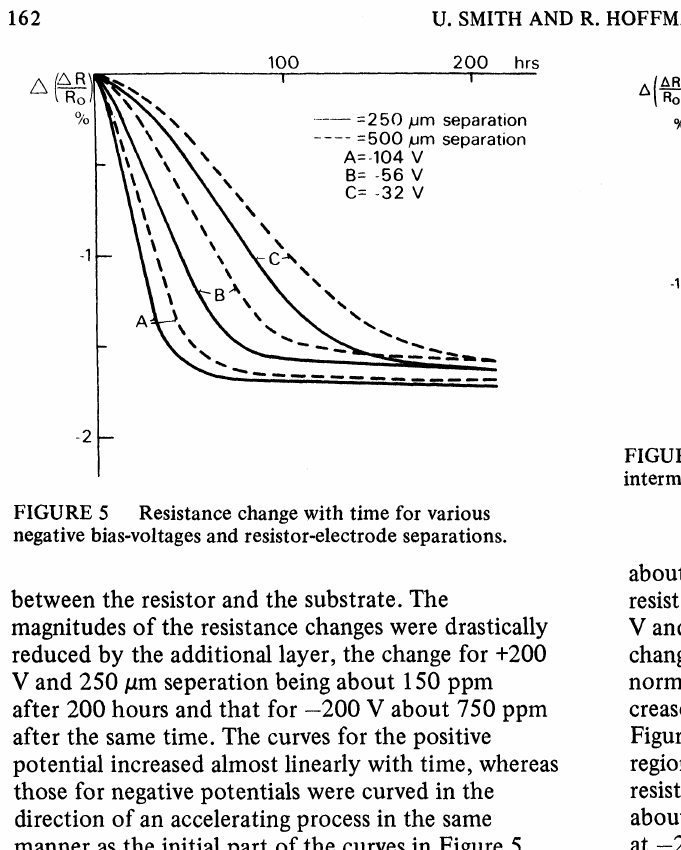
region for some time the bias was removed.